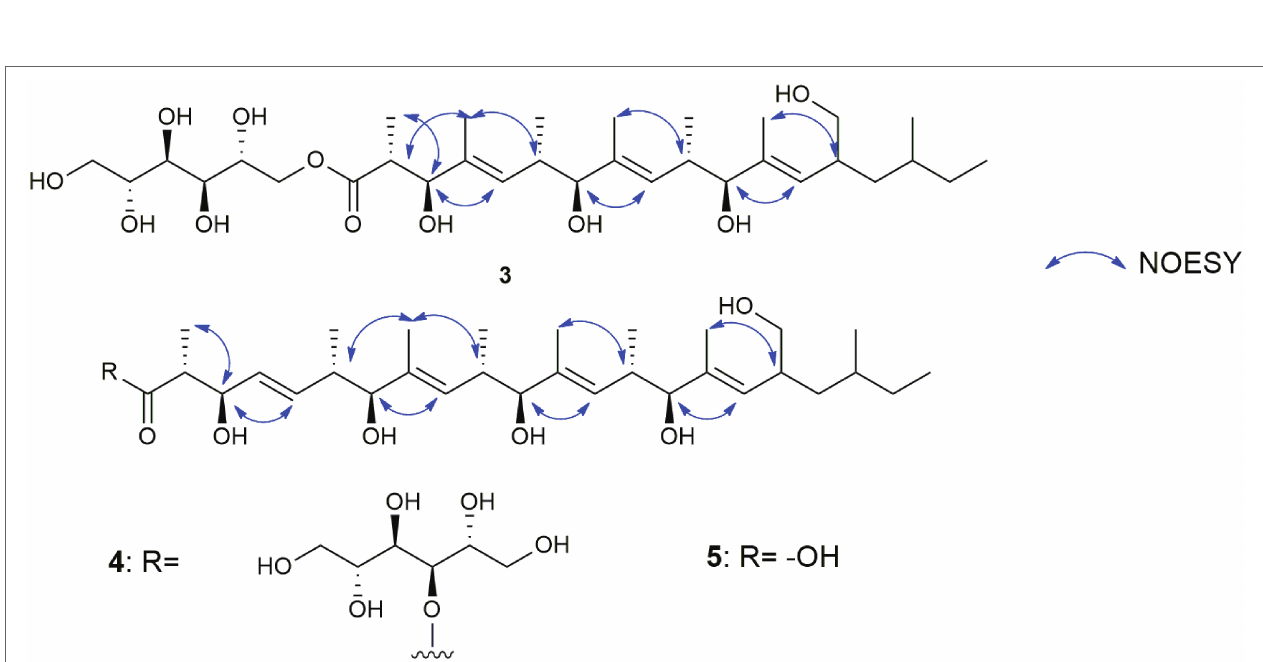
FIGURE 9 | Selected NOESY correlations of muyocopronols A ( 3 ), B ( 4 ), and C ( 5 ) to illustrate the stereochemistry of the olefin groups in the muyocopronol